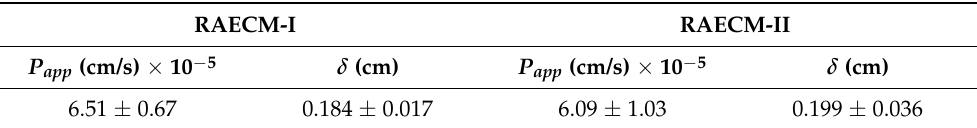
EGTA, while for other P app the correction was smaller with the smallest correction of 0.02% for P app of FITC-4 kDa dextran across RAECM-II without EGTA. Table 2. Apparent permeability ( P app ) of benzyl alcohol and unstirred layer thickness ( δ ) of RAECM-I and -II. RAECM-I